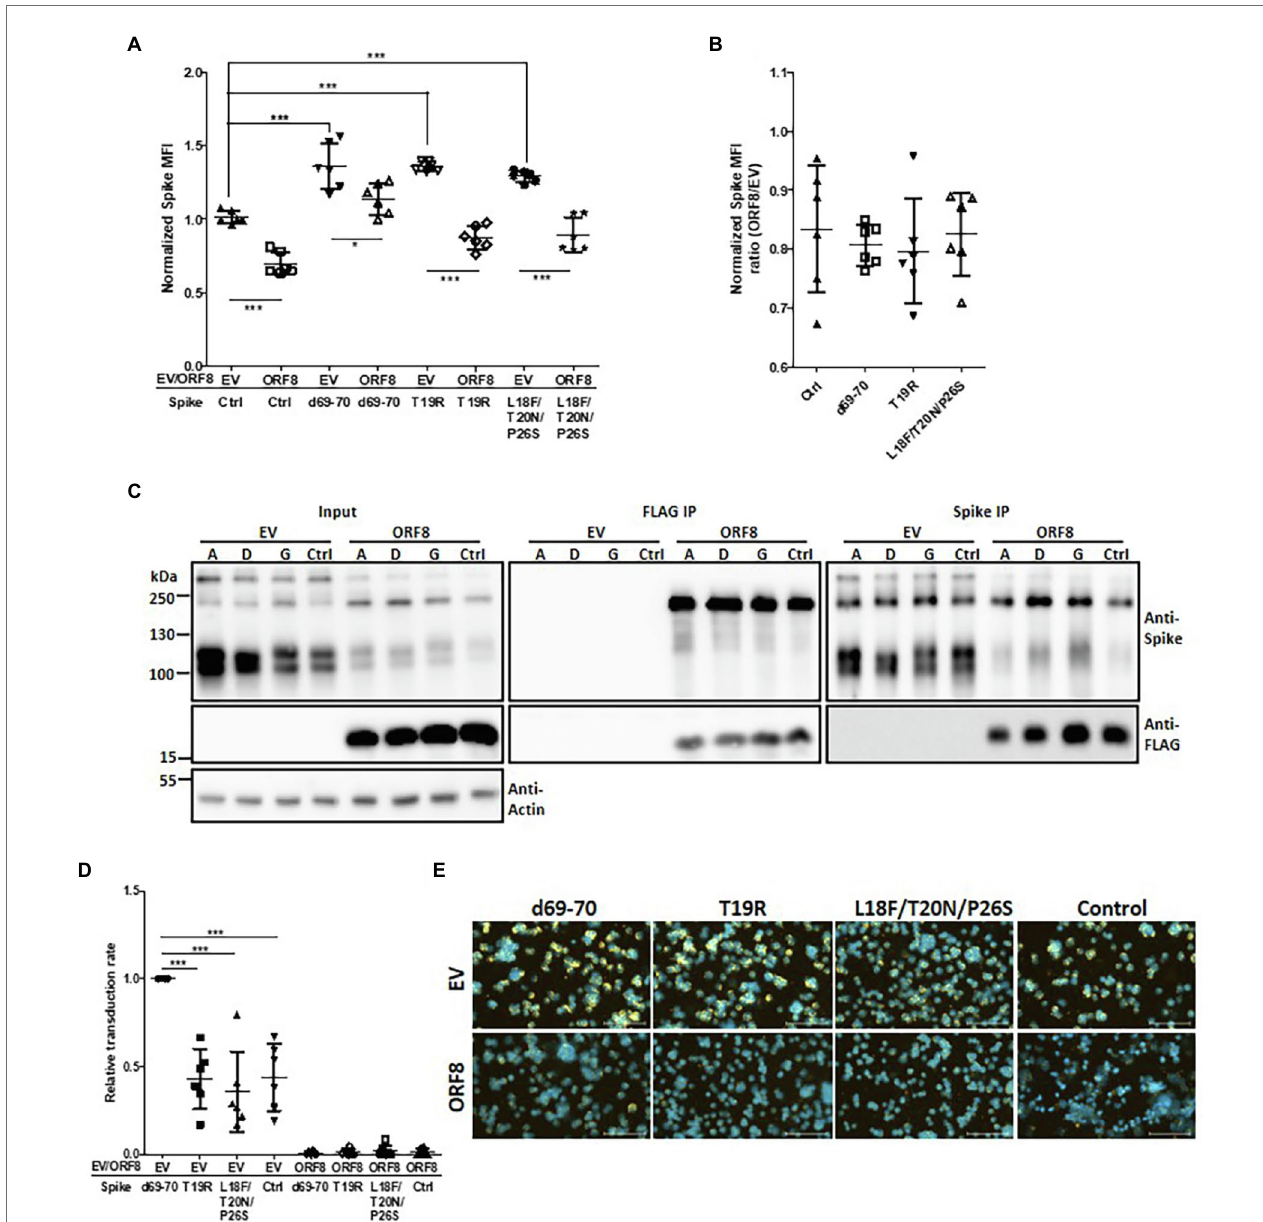
FIGURE 6 | Influence of spike mutations on ORF8-mediated downregulation of the spike protein. (A) HEK293T cells were cotransfected with the different spike- encoding plasmid together with the pLAS2-ORF8-IRES-GFP (ORF8) or pLAS2-IRES-GFP (EV) plasmid. Three days after transfection, the cells were collected for flow cytometry using antibodies against the spike protein. Here the results were collected from six-independent experiments after normalization. Ctrl: control spike plasmid without the indicated modifications. (B) The same results of (A) but shown as the ratio between ORF8 and EV groups. No significant difference was observed. (C) HEK293T cells were cotransfected with an ORF8-encoding plasmid together with a plasmid encoding spike protein with the indicated mutations. The cells were collected at 3 days post-transfection and subjected to immunoprecipitation assays. Immunoblotting analysis of the total cell lysates and the immunoprecipitates were performed using antibodies against the spike protein, FLAG tag, and actin. Abbreviations of Spike mutants: A: d69-70; D: T19R; G: L18F/ T20N/P26S. (D) Spike pseudovirions were produced using a plasmid encoding different spike envelopes together with the lentiviral vector pLAS-IRES-GFP (EV) or pLAS-ORF8-IRES-GFP (ORF8). After purification of the pseudovirions, their transduction efficiency was evaluated by exposing HEK293T/hACE2 cells to the same amount of viral supernatant. The percentages of GFP-positive cells the transduced cells were evaluated by flow cytometry and normalized with EV d69-70 sample in each experiment. (E) The relative quantity of Spike pseudoviruses in the same samples shown in (D) was evaluated by a binding assay of HEK293T/hACE2 cells exposed to the same volume of different viral samples, and samples were then visualized with a polyclonal antibody recognizing the spike protein and a Cy3- conjugated secondary antibody. DAPI was used for staining nuclei. The scatter plot figures in (A,B,D) show the mean ± SD (error bars). Unpaired Student’s t -test was used in (A,B) and paired Student’s t -test was used in (D) . p < 0.05 indicates a statistically significant difference; * p < 0.05, *** p < 0.001. The scale bar represents 100 μ